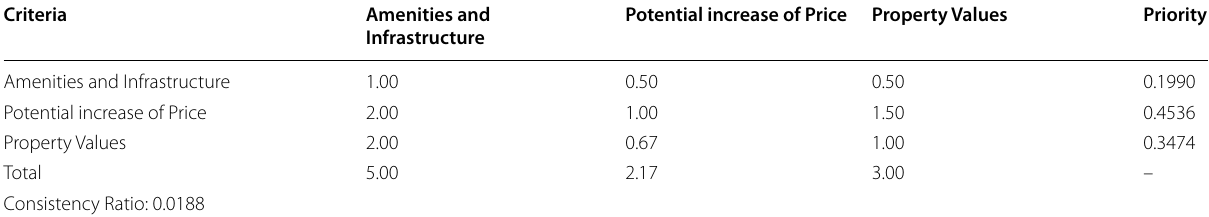
Table 3 Pairwise Comparison Matrix of the used criteria (without taking the BRT into consideration) Criteria Amenities and Infrastructure